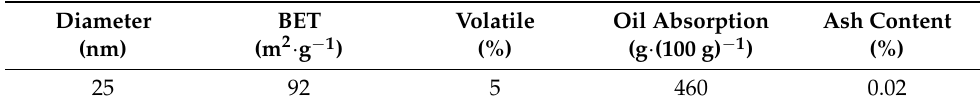
Table 1. Physical properties of carbon black.